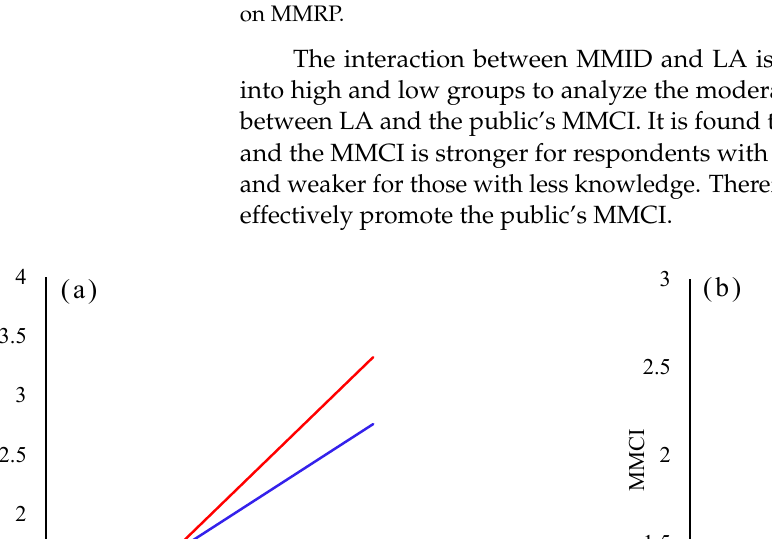
Figure 3. The Interaction between LA and MMRP. ( a ) The effect of MMRP on LA; ( b ) The effect of LA on MMRP.